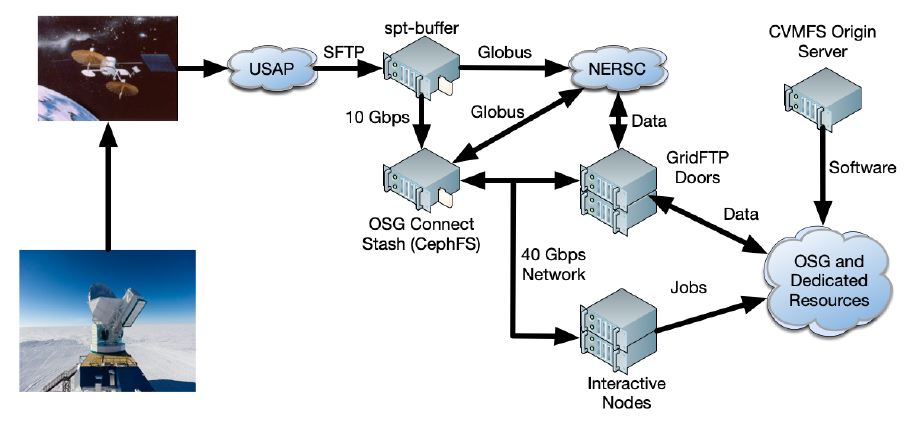
Figure 2. Overview of data and job flow for SPT. Credit: NSF / SPT / NASA